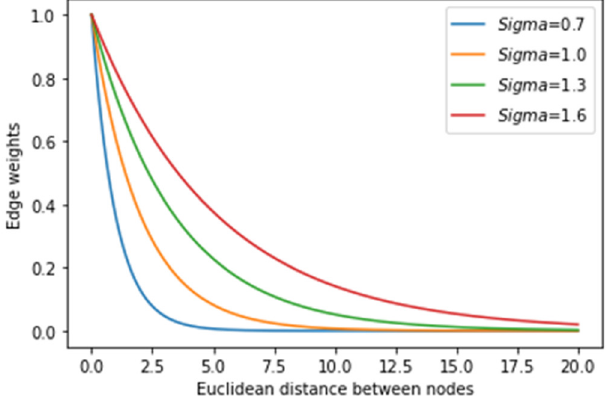
Figure 2. Edge weights between two nodes are dependent on the Euclidean distance between the brain connectomes of two nodes. Various coefficients σ (i.e., sigma values) determine the edge weight distribution.